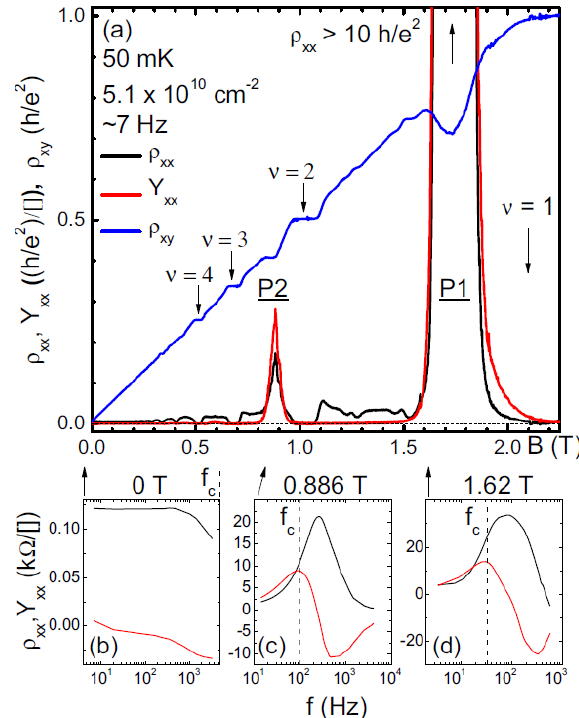
Figure 6. ( a ) Magnetoresistance of 2D holes in GaAs showing two RIPs at ν > 1 (labeled as P1 and P2). ( b ) mechanism (thermal activation vs. variable-range-hopping) ( d ) The longitudinal resistivity ρ xx and inductive signal Y xx vs. frequency at various magnetic fields, showing the clear inductive effect of the RIPs. Figure taken from Reference